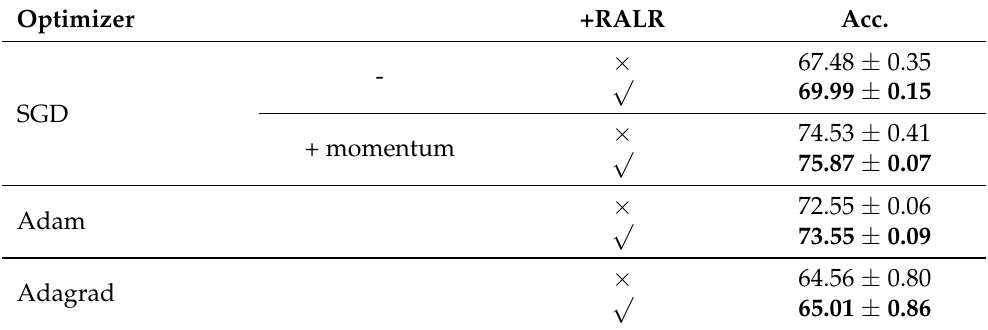
Table 6. Validation accuracy (%) over different optimizer based on ResNet-110 trained on CIFAR-100.